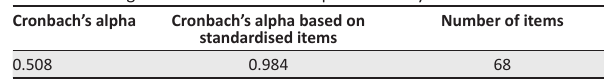
TABLE 1: Testing results for Cronbach’s alpha reliability